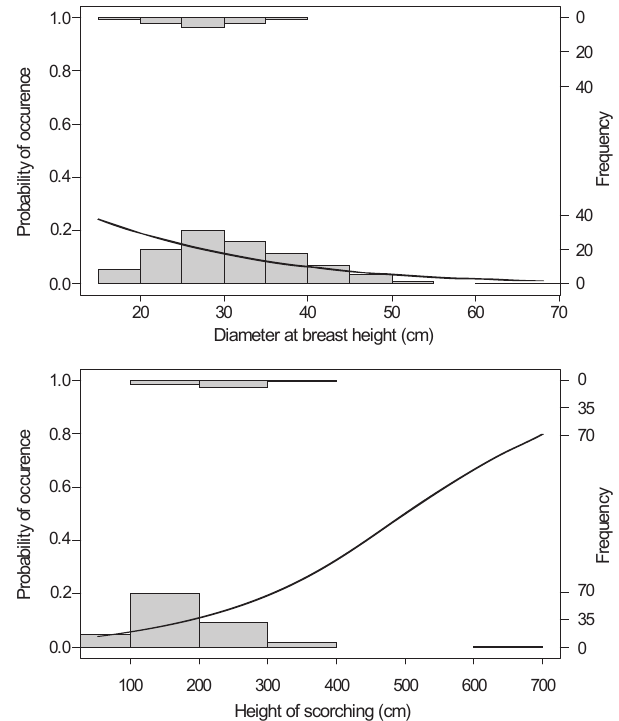
Figure 5. Result of logistic regression in the study of significance between the trees colonised by Stepha- nopachys linearis and the size of breast height and the height of the trunks’ blackened by